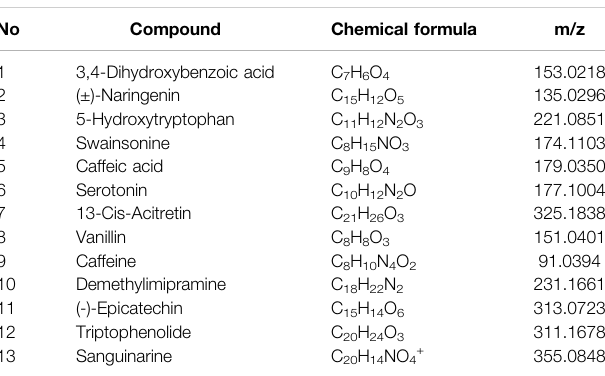
TABLE 1 | Chemical formulae of the 13 bioactive components identi fi ed from D. of fi cinale